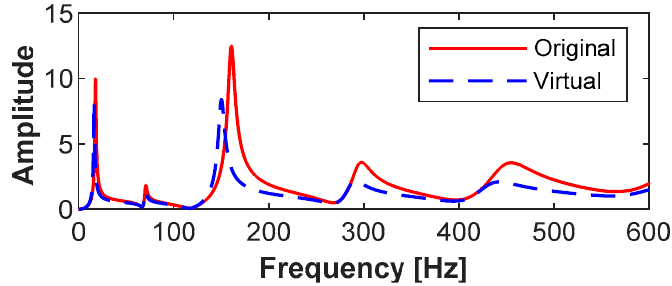
Figure 3. Frequency-domain responses of original and virtual structures.